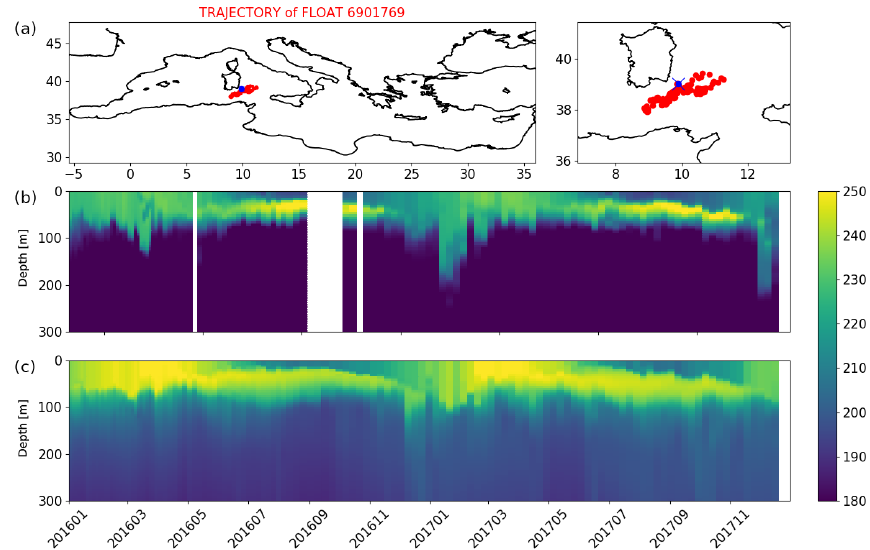
Figure 11. Time evolution of BGC-Argo float 6901769. (a) Trajectory of the BGC-Argo float (red dots) with deployment position (blue cross); Hovmöller diagrams of oxygen concentration (mmolm 3 ) of one selected BGC-Argo float 6901769 (b) and model outputs (c) matched- up with float position for the period